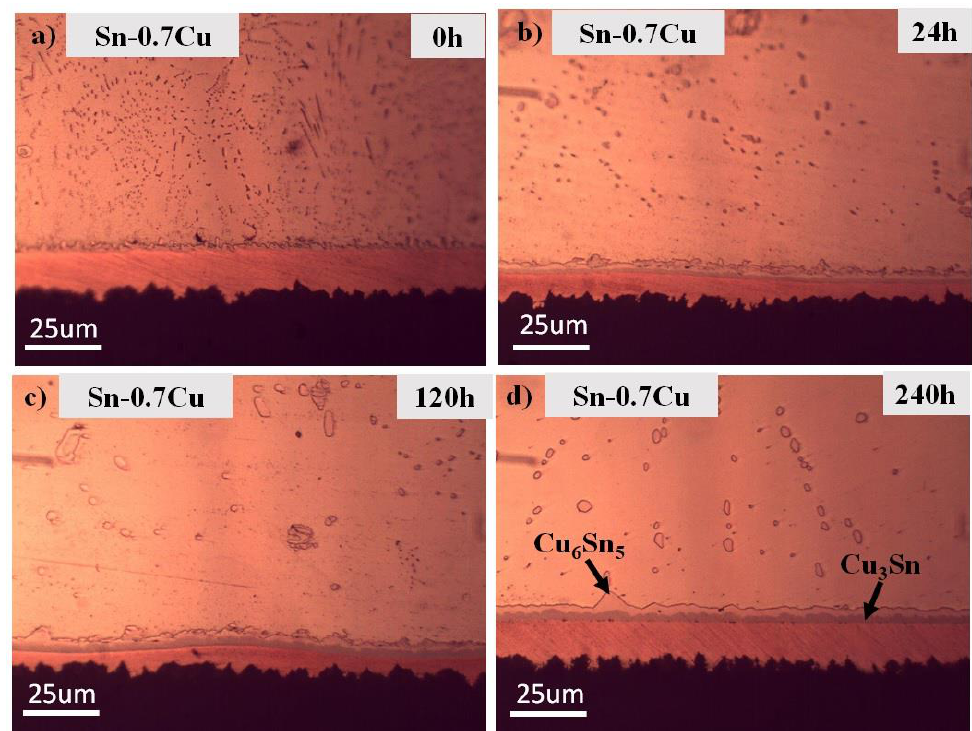
Figure 7. Microstructure of Interfacial IMC of Sn-0.7Cu after annealing at ( a ) 0 h, ( b ) 24 h, ( c ) 120 h and ( d ) 240 h at 180 °C.